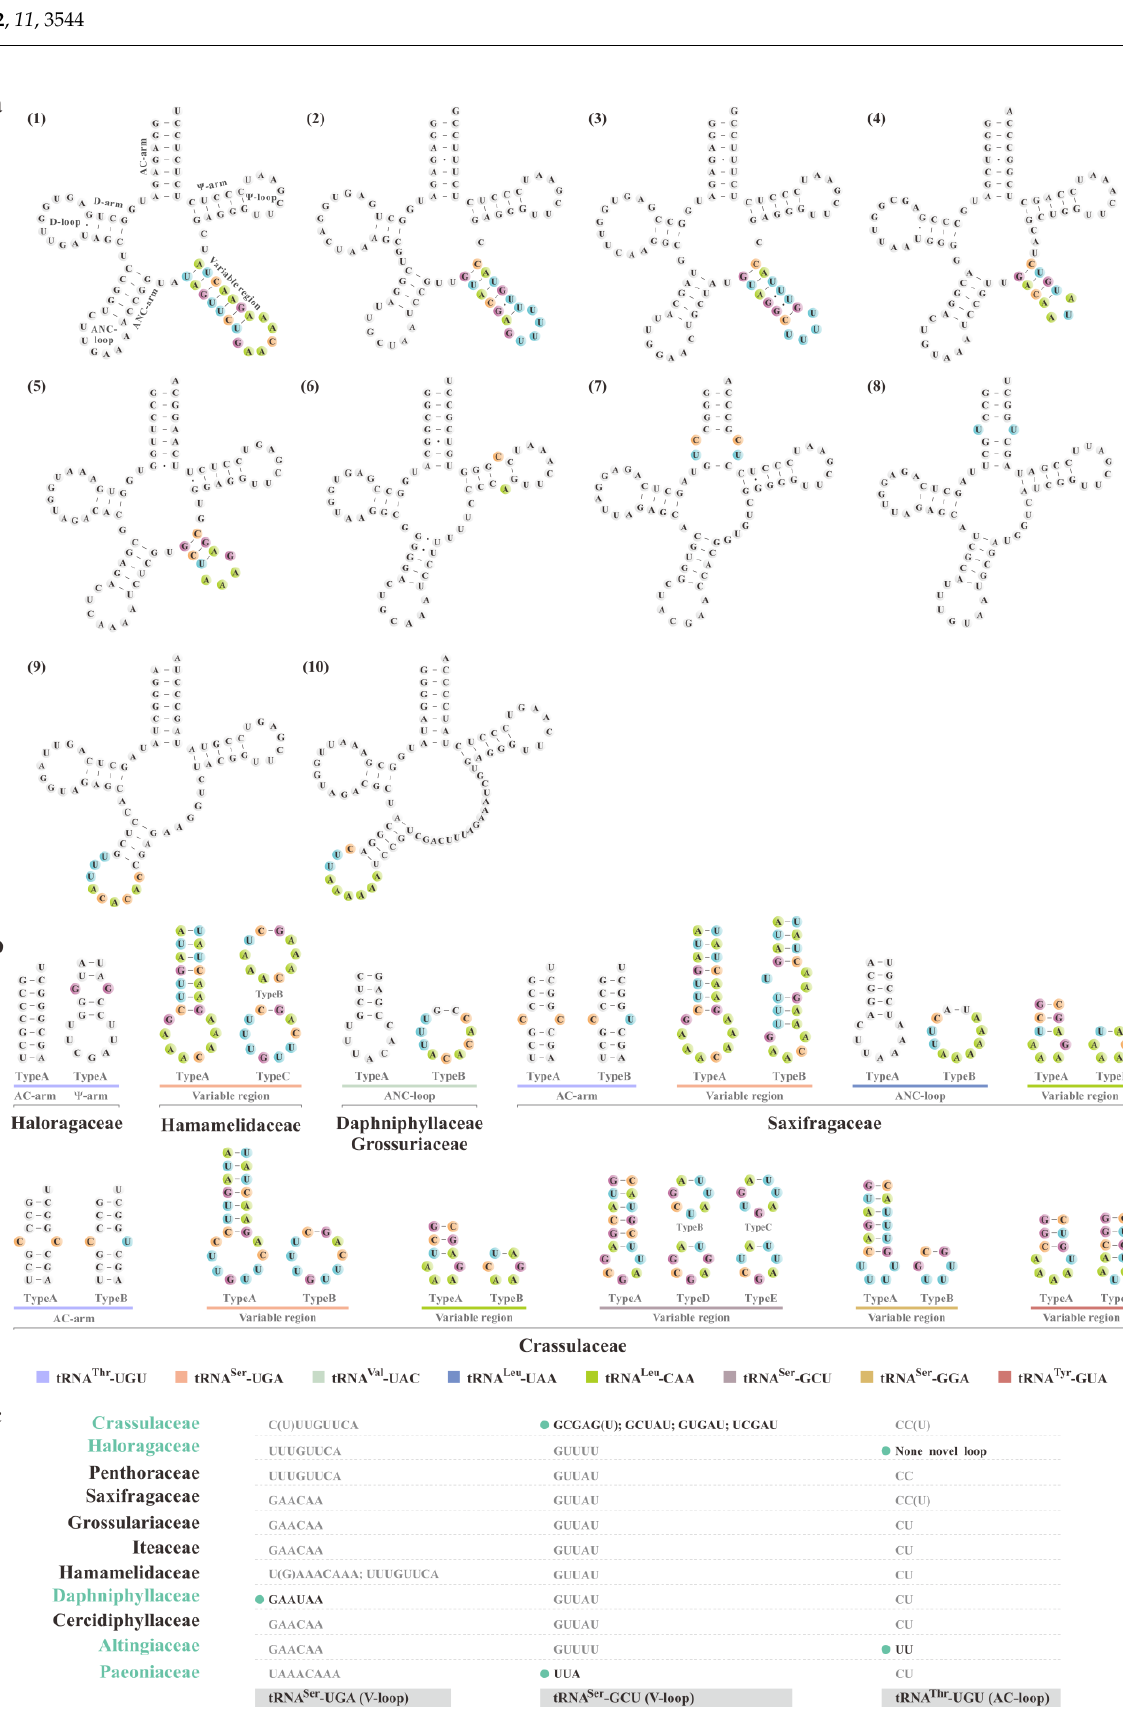
Figure 2. The pttRNAs’ structural diversifications among Saxifragales. ( a ) The predicted secondary structures of pttRNAs from Altingiaceae (as a representative) and the locations of non-typical